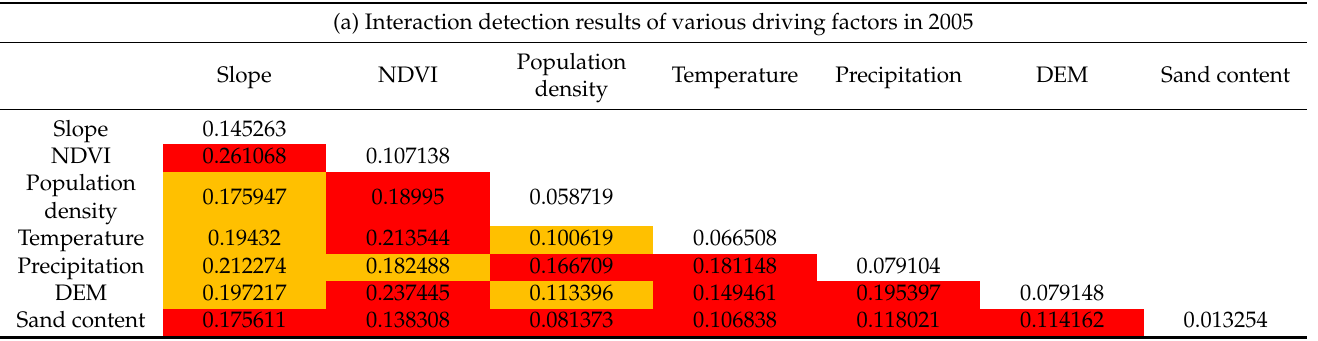
Table 5. Carbon density of various land use types in the Taihang Mountains (t · km − 2 ). (a) Interaction detection results of various driving factors in 2005